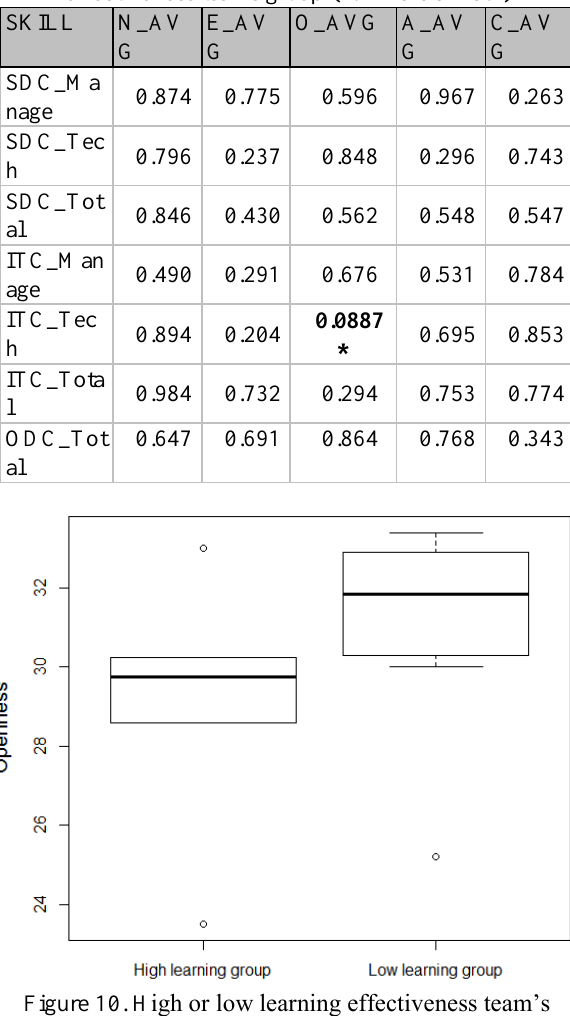
Figure 8. Histogram of individual student’s learning effectiveness in each course (left: SDC, center: ITC, right: ODC) Table 4. P value of the t-test for team average personality and learning effectiveness between high or low learning effectiveness teams group ( *: P value < 0.1 )